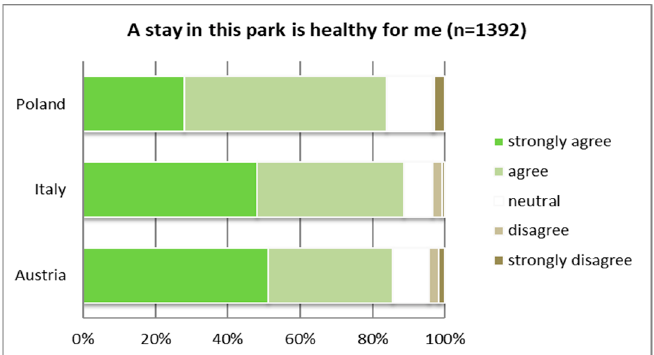
Figure 5. Benefits associated with a stay in the park and therefore contact with nature ( p ≤ 0.01).